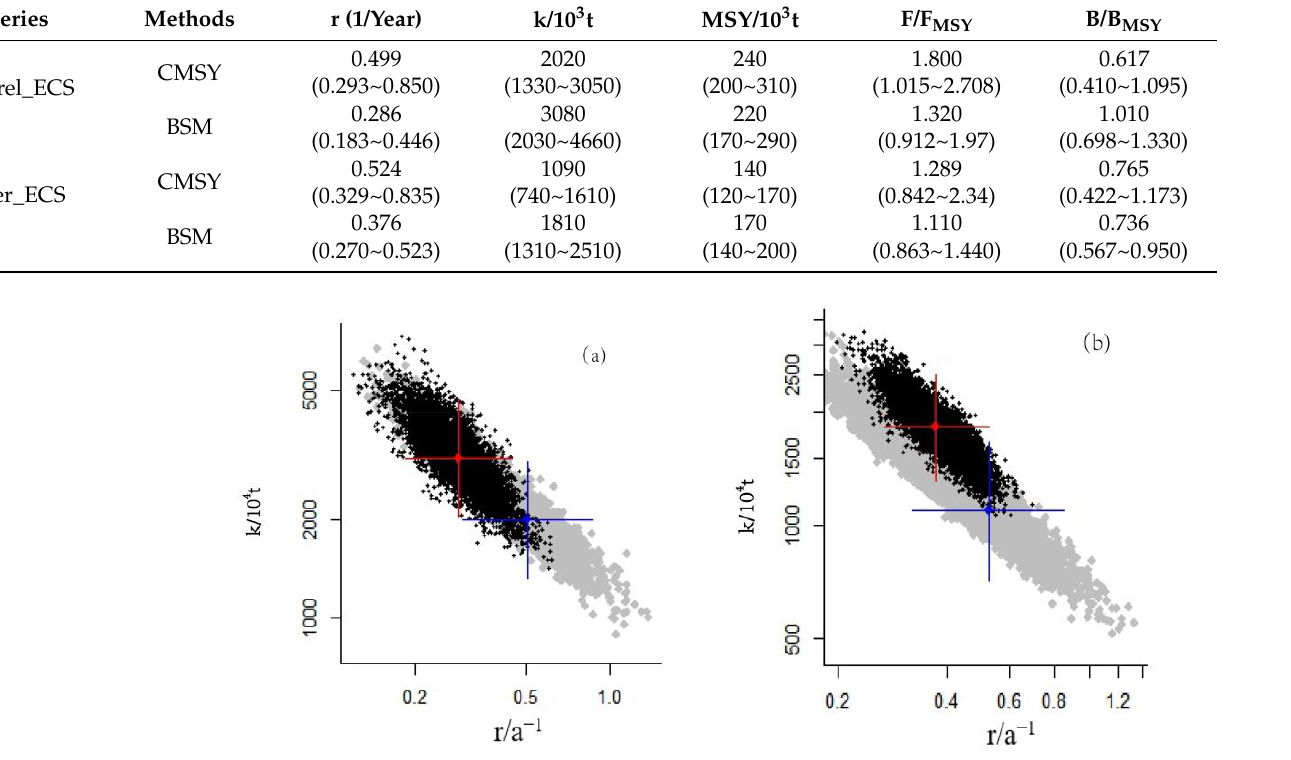
Table 4. Estimates of intrinsic growth rate, environmental carrying capacity, maximum sustainable yield, relative exploitation rate, and population biomass of the two fisheries (with 95% confidence intervals in brackets).